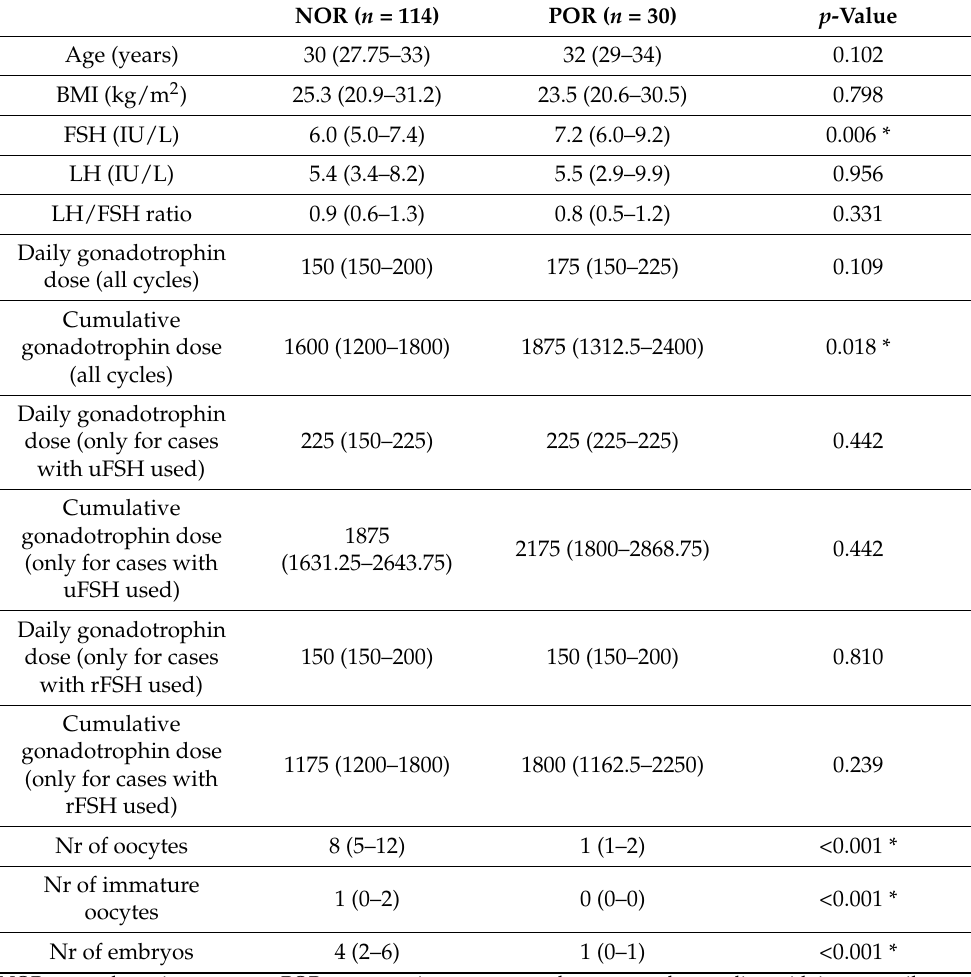
Table 1. Demographic, endocrine, and clinical characteristics of women with NOR and POR. Statisti- cally significant differences are marked with an asterisk ( p -value <